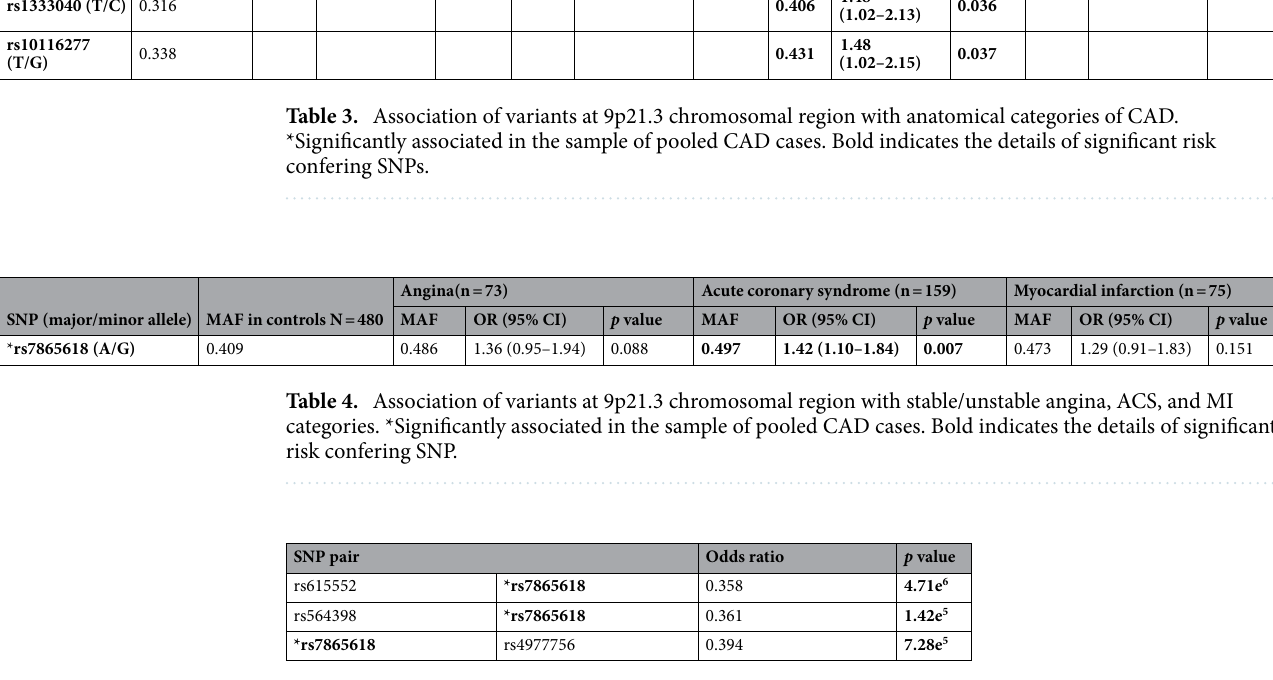
Table 5. Significant SNP-SNP interaction effects on CAD obtained through pair wise logistic regression. *SNP significant for allelic and genotypic association with CAD. Bold indicates the significant risk conferring lone SNP and the p values of